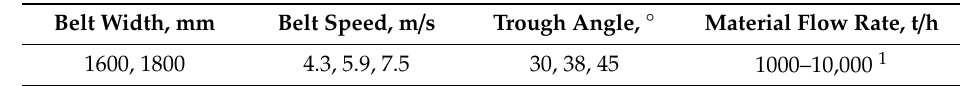
Table 1. Conveyor design parameters.